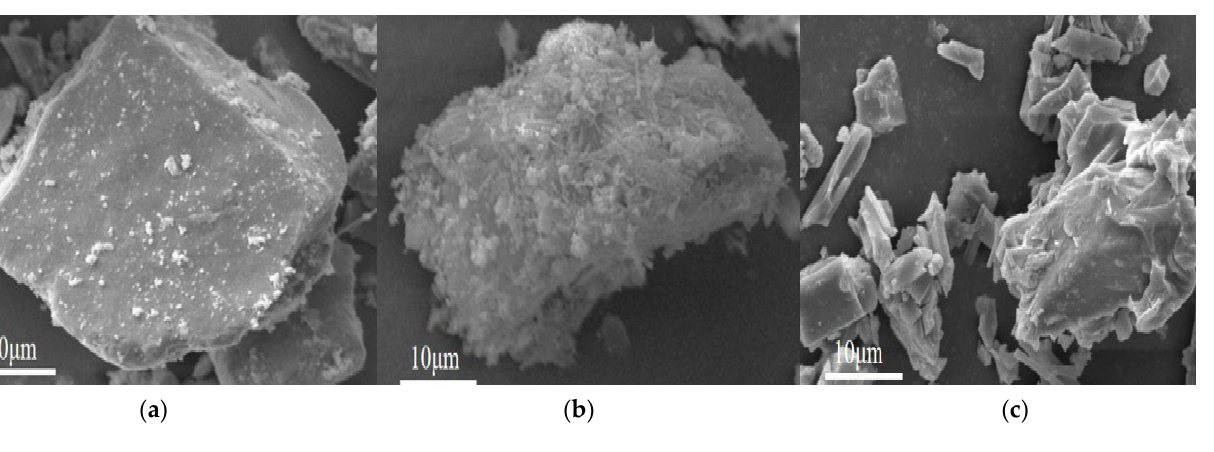
Figure 2. The SEM imagines of RP ( a ), Mic − MBP ( b ), and Mic − DP ( c ).